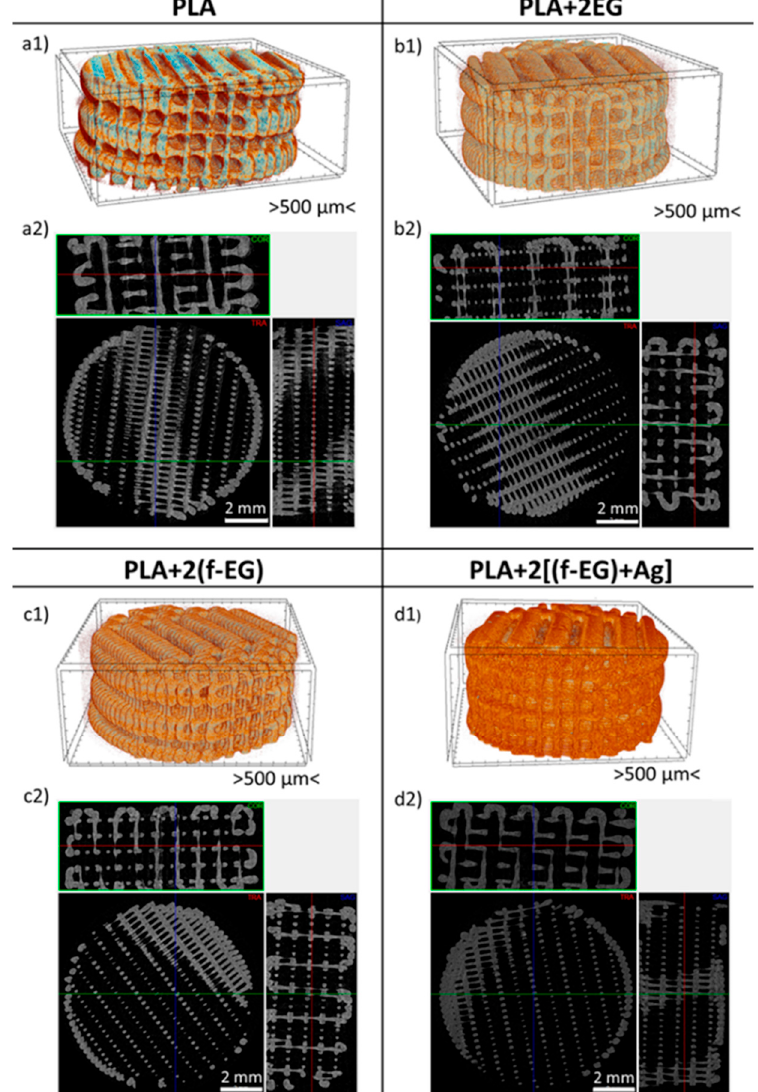
Figure 6. Representative 3D micro-CT reconstruction and the corresponding micro-CT cross-sections images of the 3D-printed scaffolds containing: ( a1 , a2 ) PLA; ( b1 , b2 ) PLA+2EG; ( c1 , c2 ) PLA+2(f-EG); and (d1 , d2) PLA+2[(f-EG)+Ag].